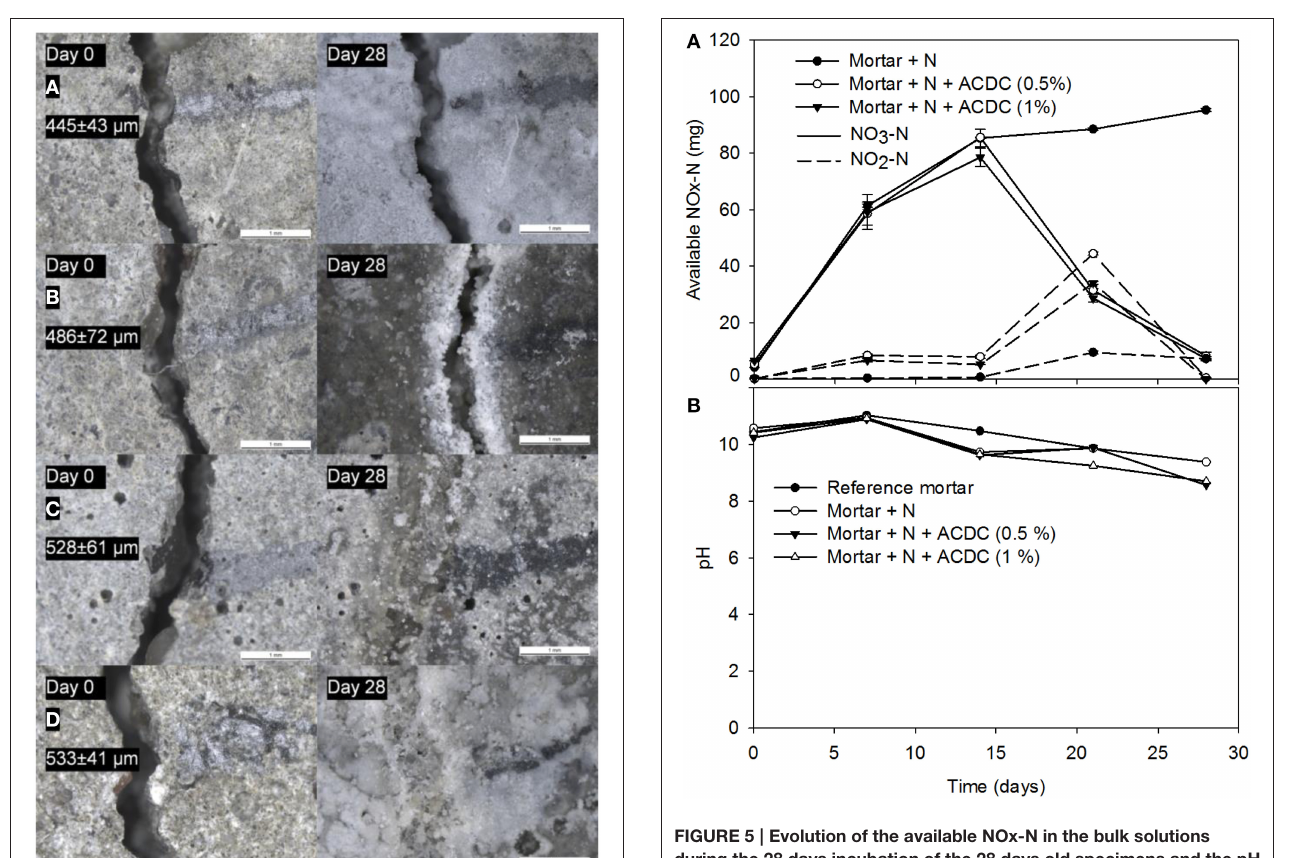
FIGURE 5 | Evolution of the available NOx-N in the bulk solutions during the 28 days incubation of the 28 days old specimens and the pH of the solution (A) mass of the available NOx-N (B) the pH change [N: Nutrients – 2% Ca(HCOO) 2 + 3% Ca(NO 3 ) 2 ; n = 3 , error bars represent the standard